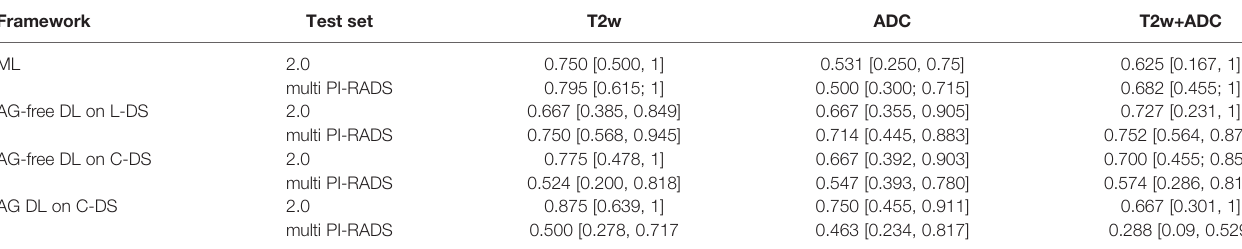
TABLE 2 | AUROC values of ML and DL analyses for T2w/ADC/T2w+ADC.